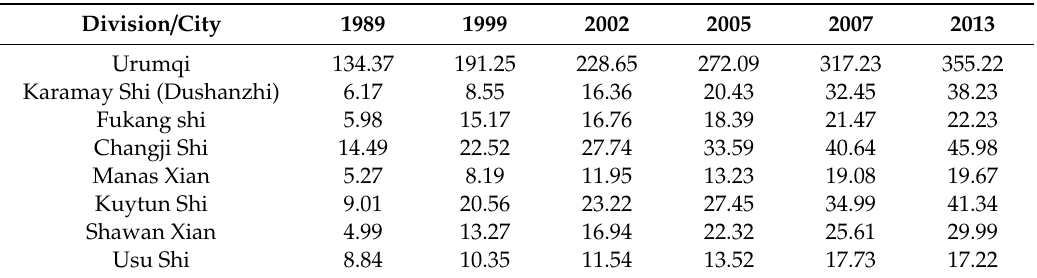
Table 5. CA of built-up areas that changed (in the Autonomous prefectures) Unit: km 2 . Division / City